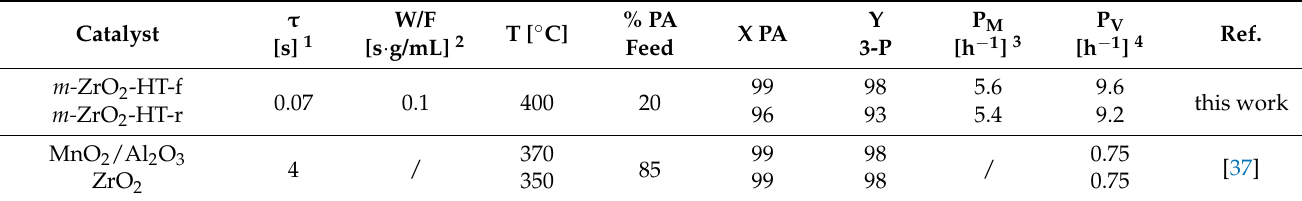
Table 3. Comparison between m-ZrO 2 -HT-f (=fresh), m-ZrO 2 -HT-r (=regenerated), and other catalytic systems reported in patents and academic literature. Symbols: τ = contact time, W/F = time factor, T = reaction temperature, % PA feed = mol % of propionic acid in the feed, X PA = conversion